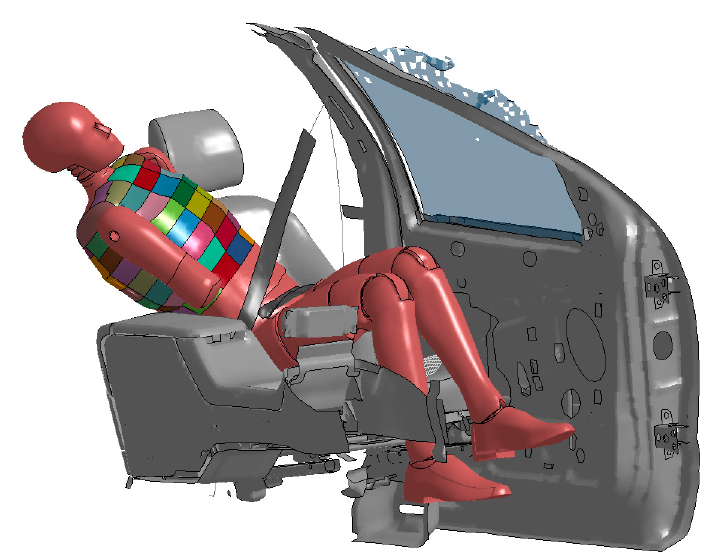
Figure 9. Position 8—ATD with the right thorax impacting the centre console at 2300 ms.